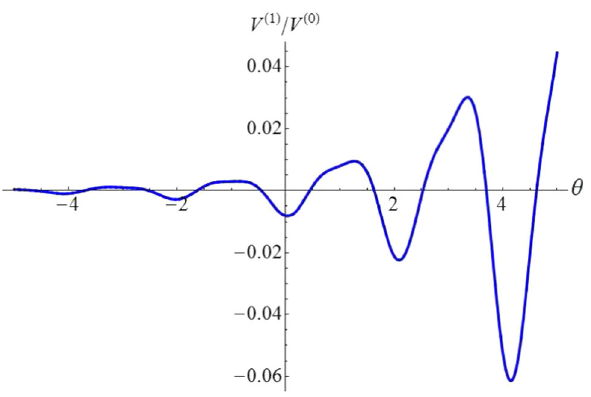
Fig. 2 Linear instability of the special solution (3) for K 1 = K 2 = 0 . 01 , K 3 = 0 , ϕ 1 = ϕ 2 = 0 for the perturbations of the scale factors ( α, β, γ ), respectively. The graph presents the parametric curve defined by the time dependence of α/ a , β/ b , and γ/ c